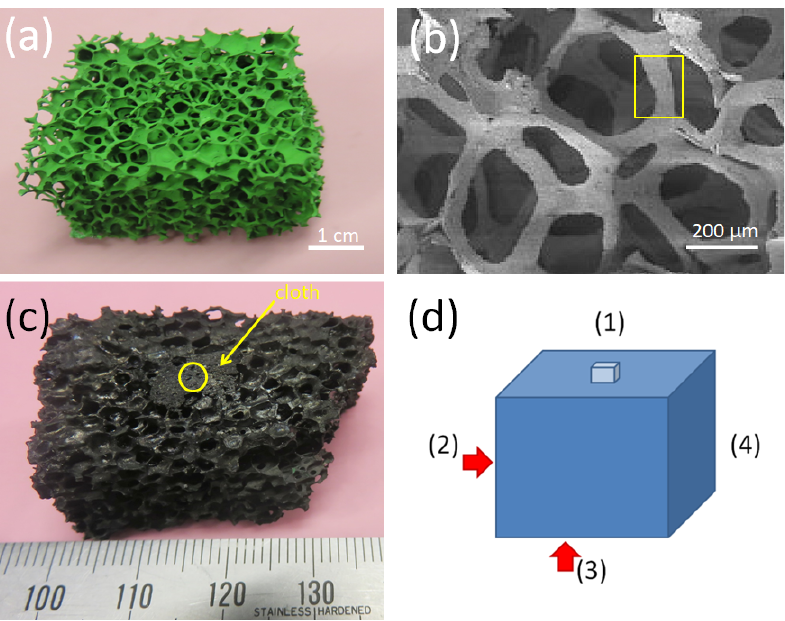
Figure 1. ( a ) Image of the preform stage: A green 211 foam. ( b ) SEM image of the 3D structure of the 211 foam. The yellow rectangle marks the central piece of a strut as analyzed by magnetic measurements and for the microstructure investigation. ( c ) presents the fully reacted, superconducting foam. On the top Side (1), the remains of the seed crystal (yellow circle) and a YBCO cloth (yellow arrow) are still visible. ( d ) gives a schematic drawing of the foam sample and the nomenclature of the sample